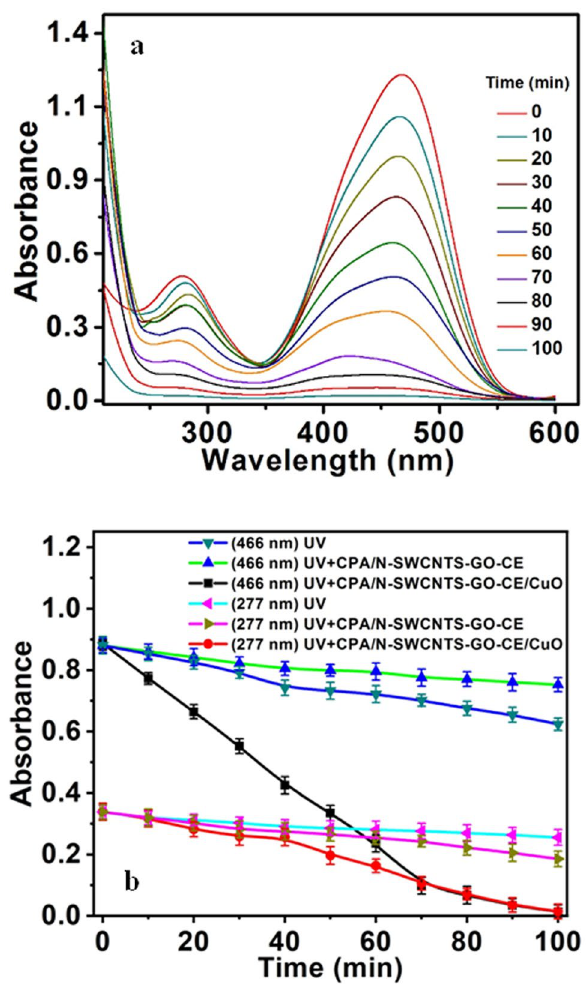
Figure 9. ( a ) photo-absorption spectral measurements of methyl orange in the presence of CPA/N-SWCNTs- GO-CE/CuO nano-catalysts using 50 mg/L nano-catalysts, MO 10 mg/L and at pH 6; ( b ) Alterations of the absorbance spectra versus time at wavelengths of 277 and 466 nm in three different cases UV radiation, in the presence of PCP-CNTs and nano-catalysts in presence of UV radiation.